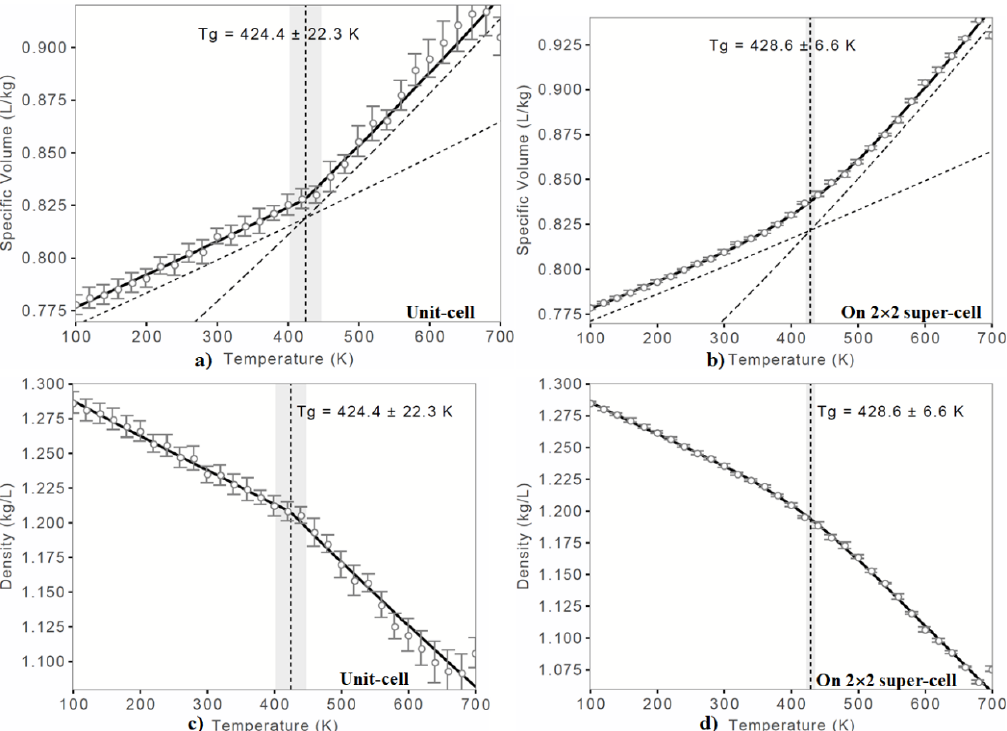
Figure 2. Dilatometric results of o-PEEK, where the equilibrium start- and end-temperatures were 700 K and 100 K, respectively, with the step size of 30 between them. ( a) –( b ) Specific volume vs. Temperature and ( c)– ( d ) Density vs. Temperature. The glass transition temperature ( T g ) with standard deviation is shown for each case.